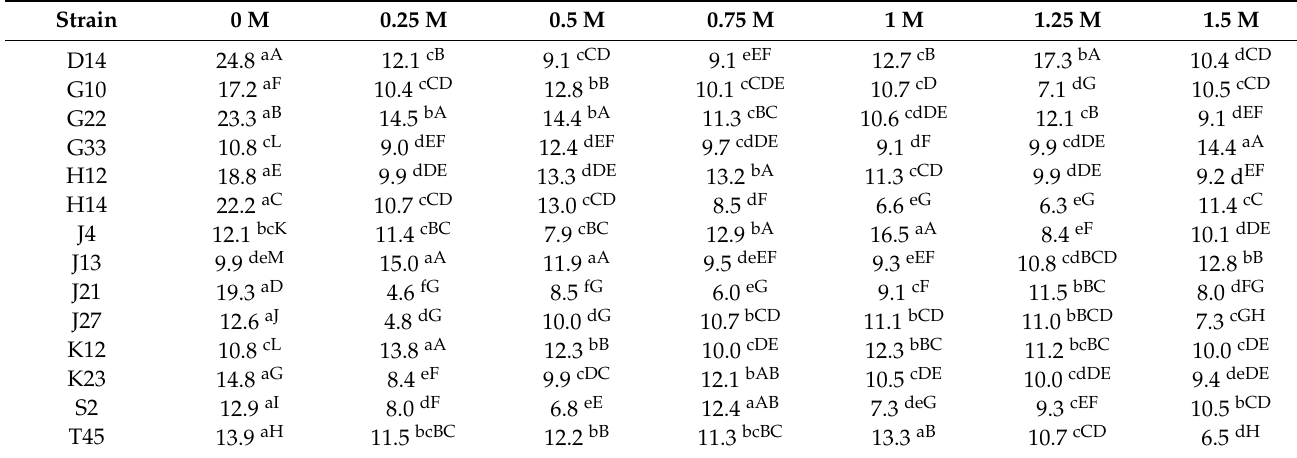
Table 1. Concentrations of phosphorus ( µ g PO 43 − mL − 1 ) solubilized by the actinomycetes strains under different NaCl con- centrations.